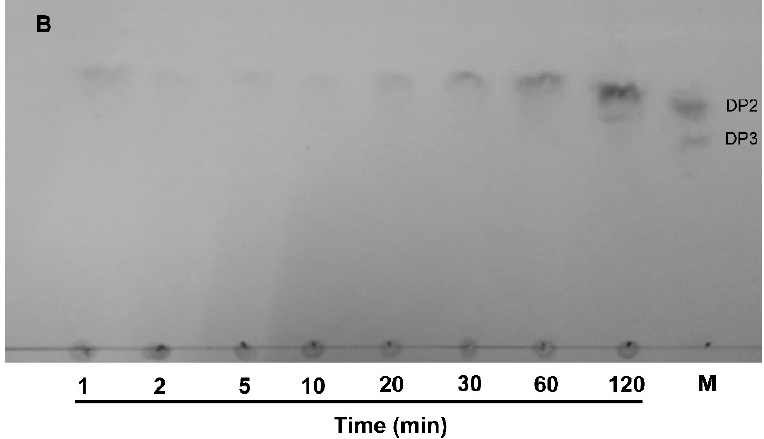
Figure 6. The action pattern of VsAly7D. ( A ) The relative viscosity and the change of A235 during the process of degradation. The solid line represents the relative viscosity, and the dotted line represents A235. ( B ) The time course of the degradation products by VsAly7D analyzed by TLC. M means the maker containing unsaturated alginate disaccharide and trisaccharide.